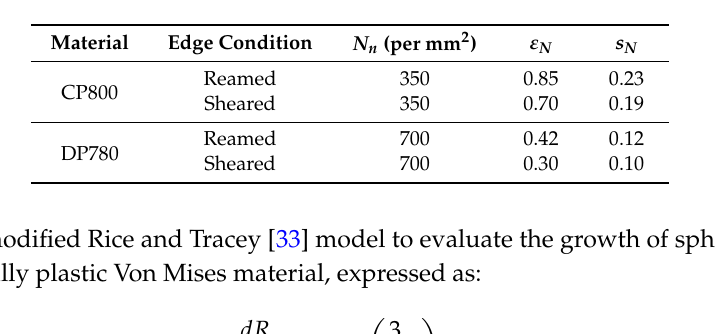
Figure 24. The implementation of Chu and Needleman’s nucleation rule using Equation (5) for the ( A ) CP800 and ( B ) DP780 steels. Table 4. Nucleation parameters for the reamed and sheared holes of the CP800 and DP780 steels indicated in Equation (5).